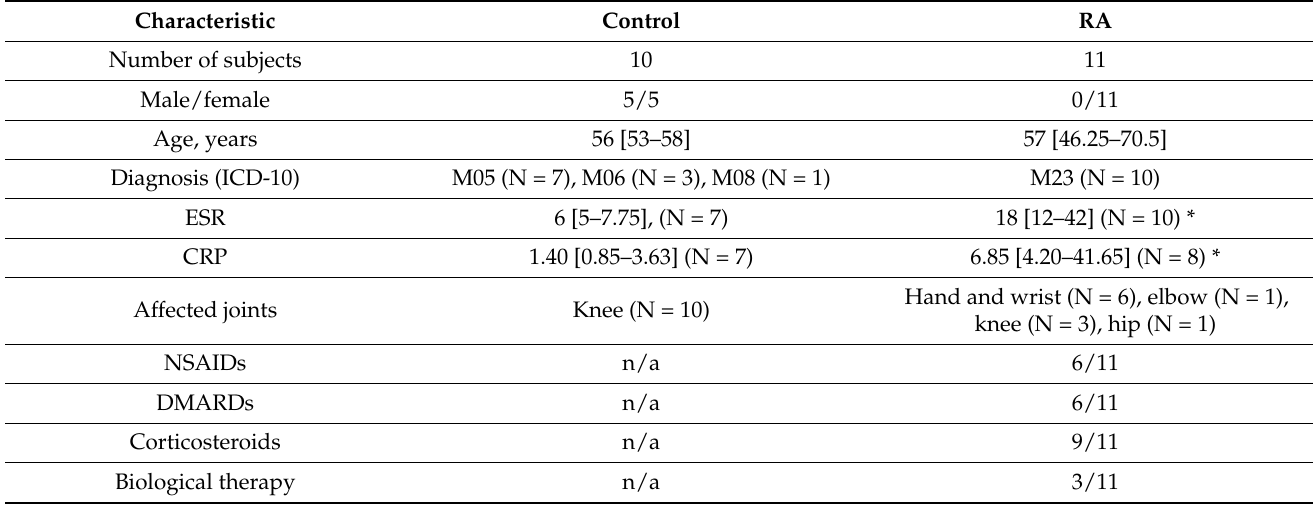
Table 2. Selected demographic and clinical characteristics of control subjects and patients with rheumatoid arthritis